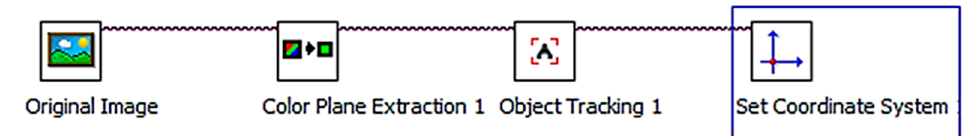
Figure 4. Image Analysis Steps.